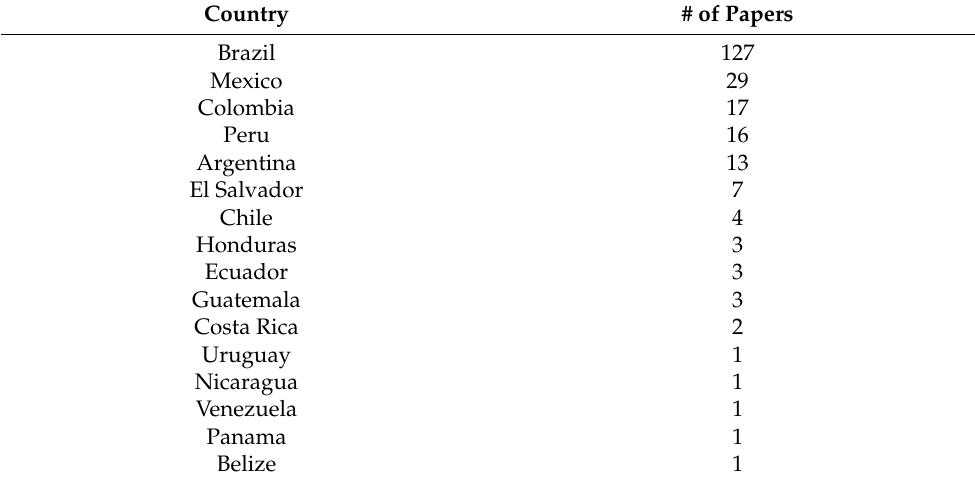
Table 1. Number of papers per